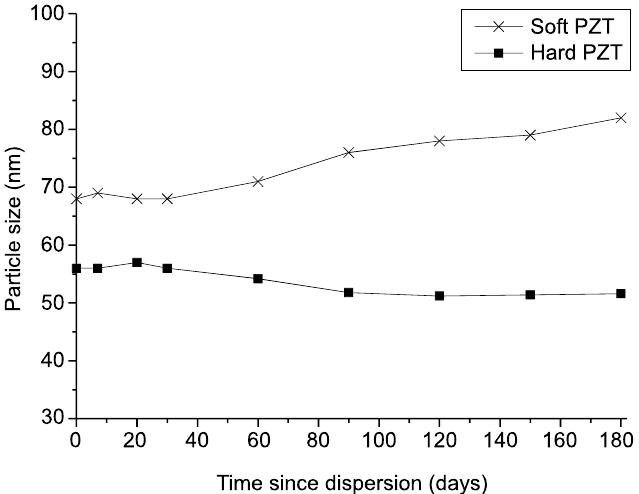
Figure 10. Variations in the particle size distributions of TiO 2 colloids (1 wt.%) with